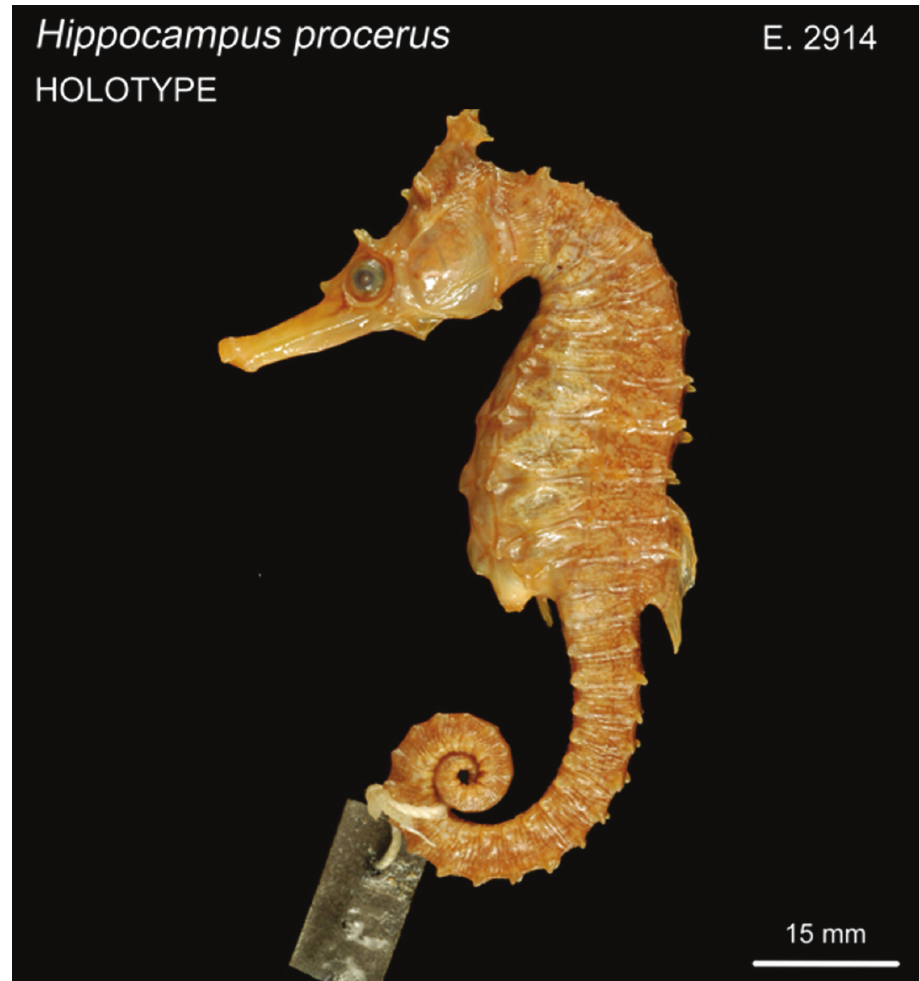
Figure 5. Hippocampus procerus , AMS E2914, adult female, holotype, 120 mm SL, Hervey Bay, Queens- land, Australia (photograph Mark